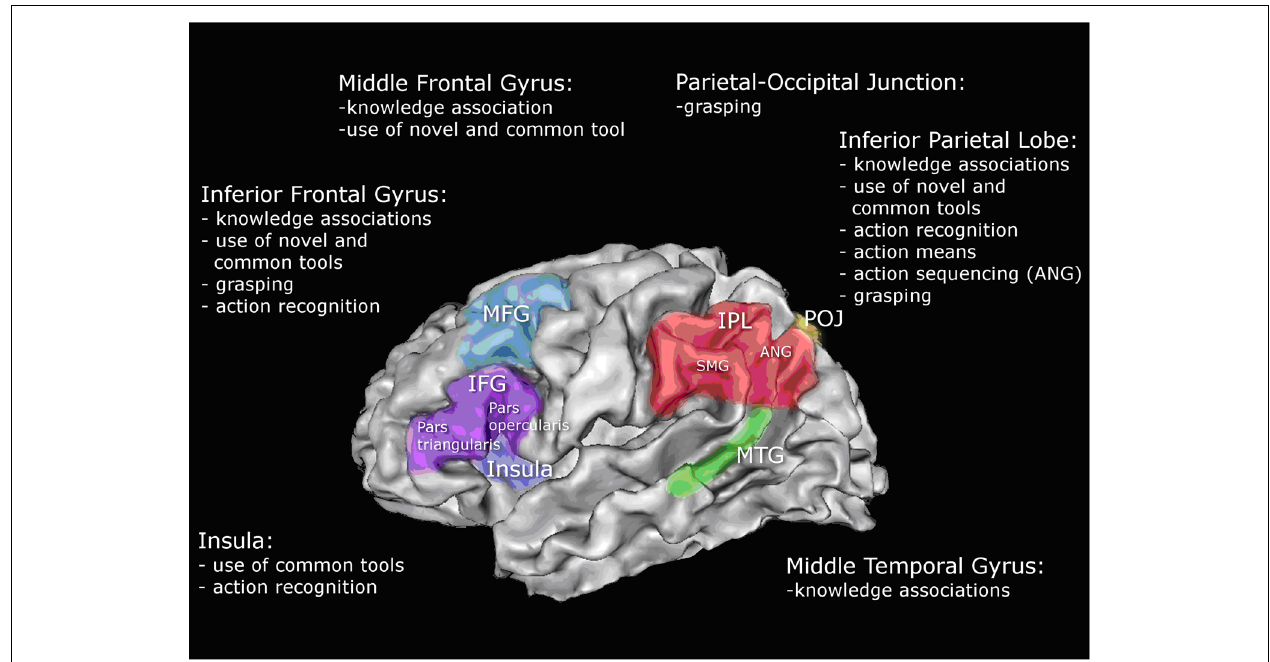
FIGURE 2 | Schematic illustration of left hemisphere associations with performance in tool use andADL based on the reviewed studies; middle frontal gyrus (MFG); inferior frontal gyrus (IFG); inferior parietal lobe (IPL); supramarginal gyrus (SMG); angular gyrus (ANG); parietal-occipital junction (POJ); middle temporal gyrus